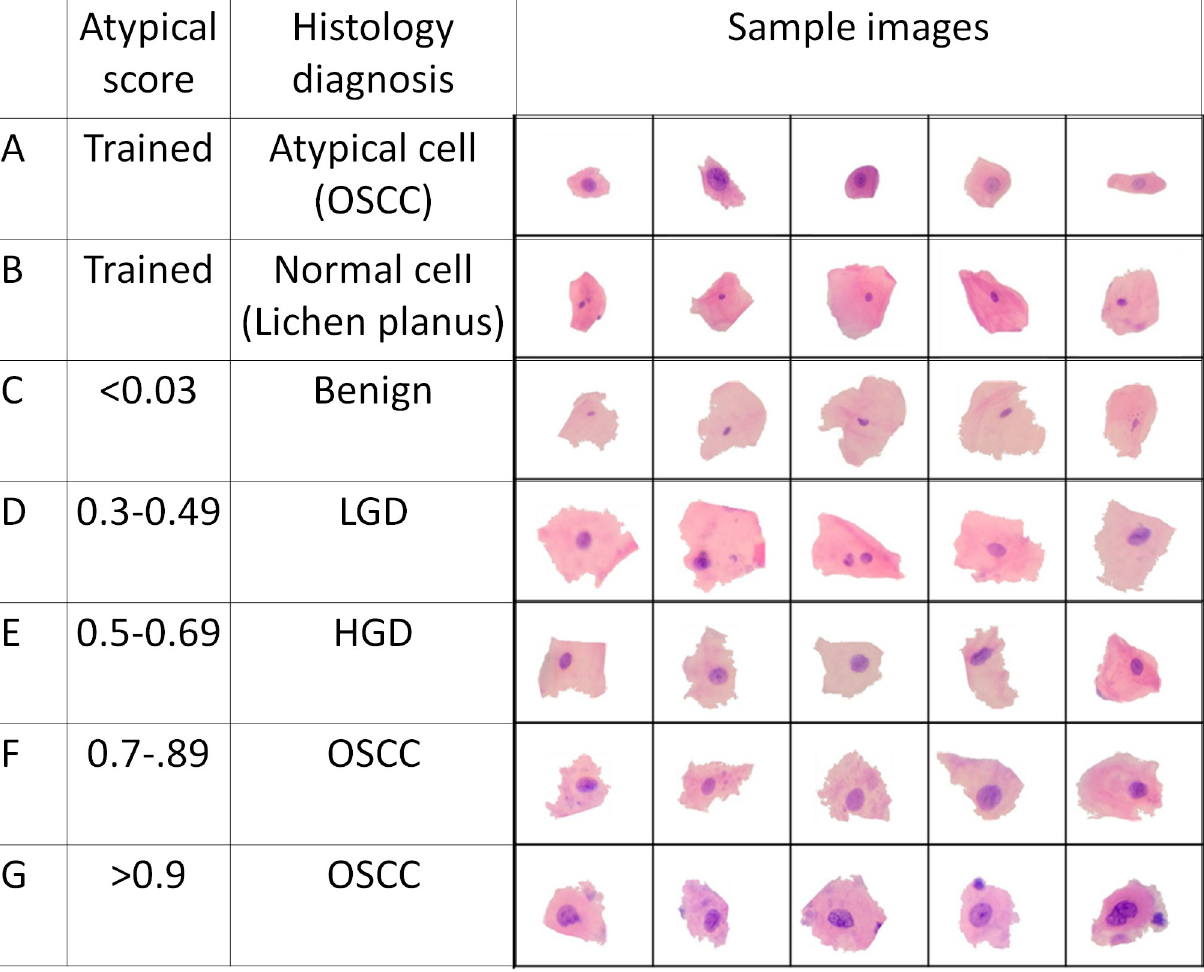
Fig 3. A batch of trained and validated cell images. Images of atypical cells(a) and normal cells (b) used for training the ANN. Cells classified by ANN: cells having atypical score less than 0.3 (c) from benign subjects, cells with atypical score between 0.3 to 0.5 from LGD patients(d), cells with atypical score between 0.5 to 0.7 (e) from HGD patients, cells with atypical score between 0.7 to 0.9 (f) from OSCC patients and cells with atypical score greater than 0.9 (g) from OSCC